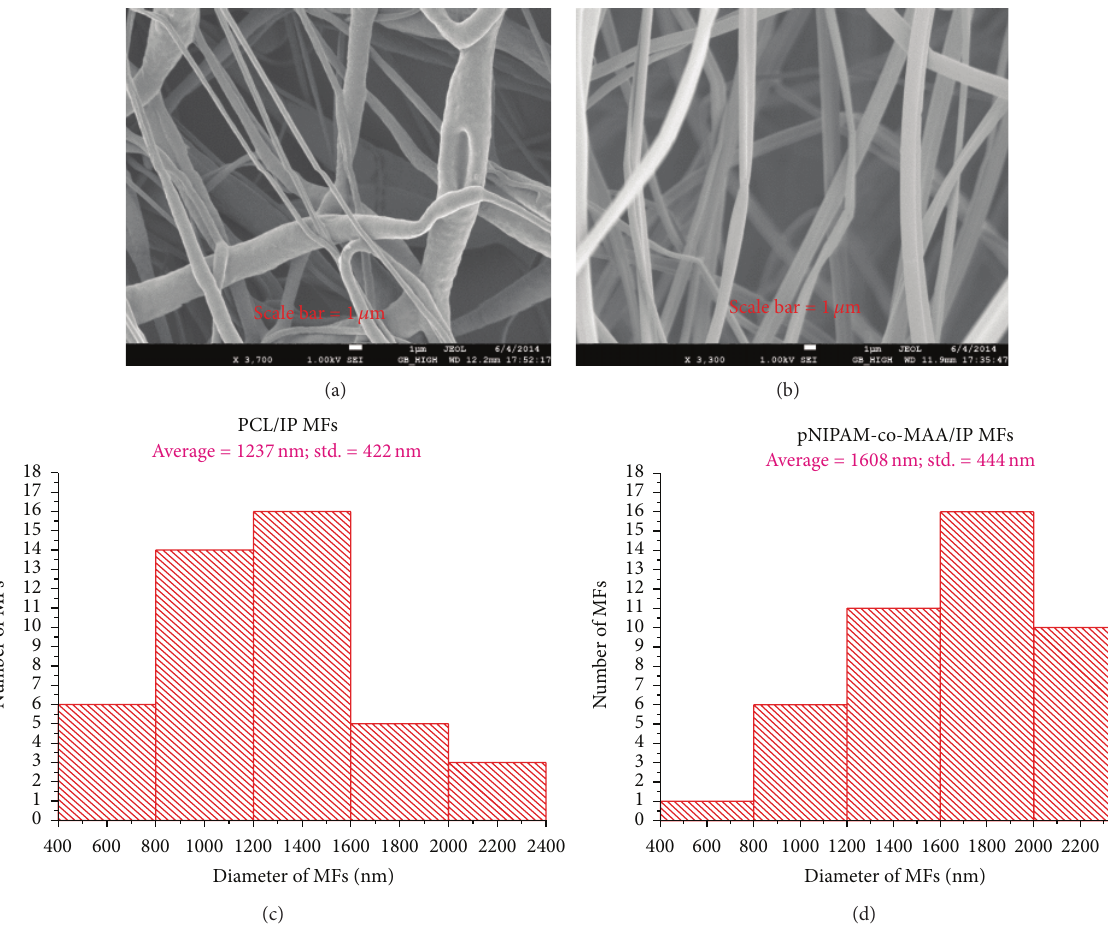
Figure 2: Scanning electron spectroscopy images of (a) PCL/IP MFs; (b) pNIPAM-co-MAA/IP MFs; (c) and (d) are their diameter distribu- tion histograms,